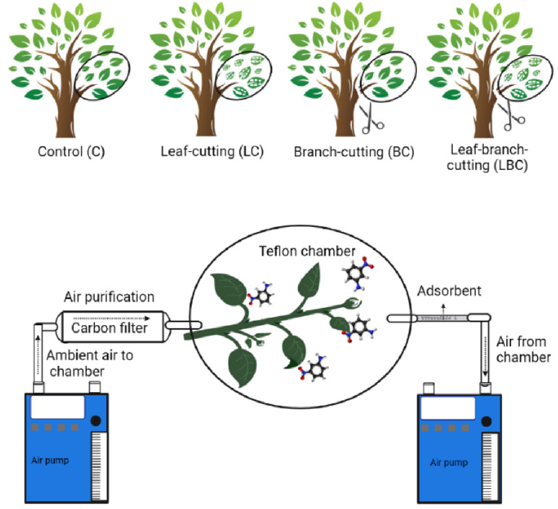
Figure 1. The experimental manipulations applied to four Ficus trees before biogenic volatile organic compound (BVOC) sampling ( top ), and a simplified illustration of the equipment setup used for the BVOC sampling ( bottom ).